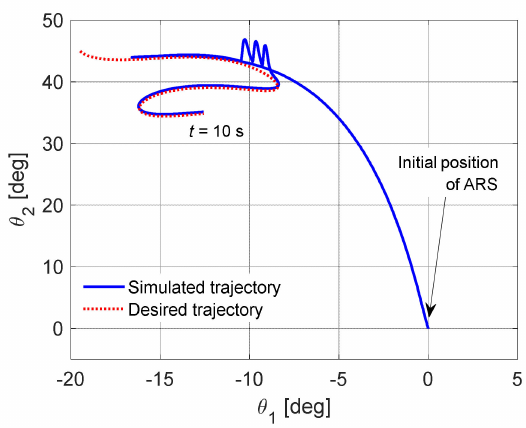
Figure 8. Simulated and desired trajectory of ARS with interference—PID control.